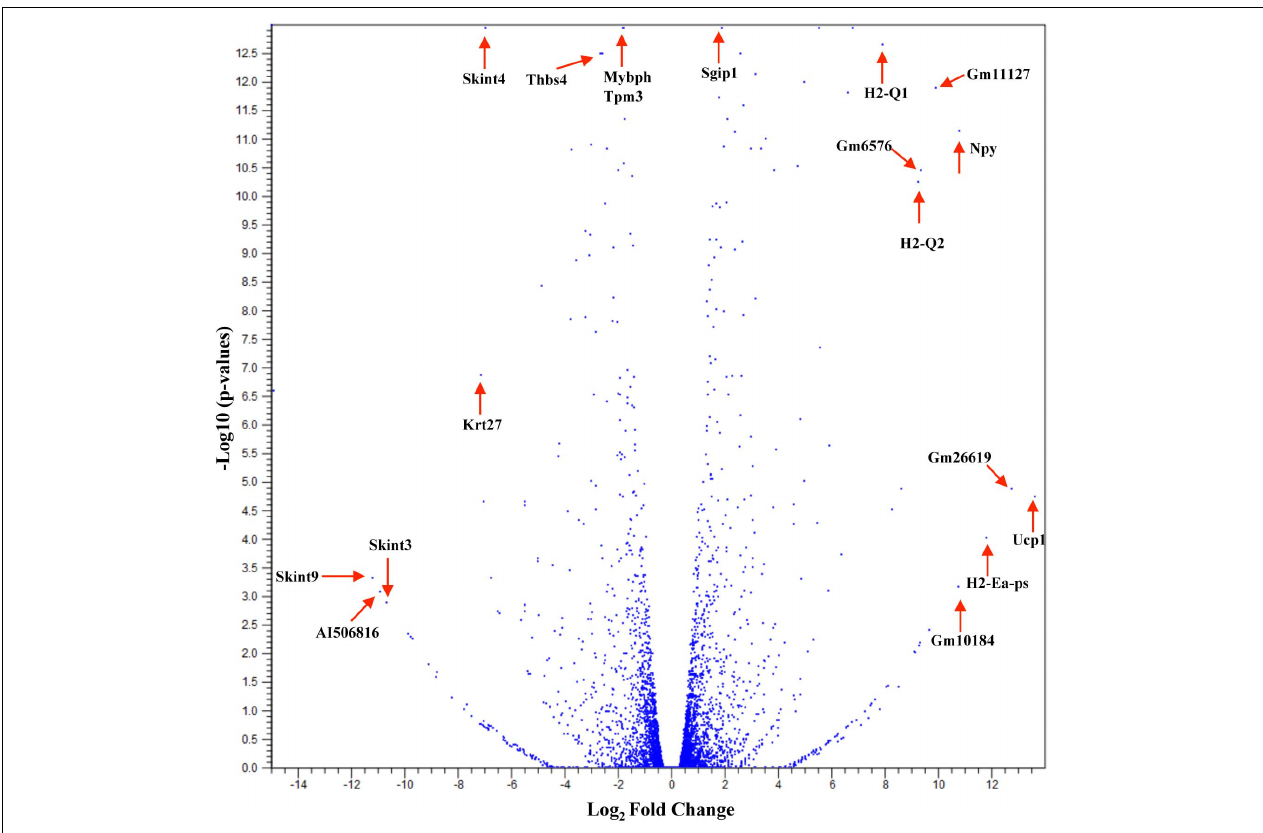
FIGURE 2 | Overall cutaneous gene expression changes in BALB/c versus C57BL/6 skin. Total RNA was isolated from untreated C57 and BALB/c normal skin samples and subjected to transcriptome analysis by MiSeq ( n = 6/experimental group). Volcano plot comparing gene expression levels in terms of log 2 fold change versus significance in both group comparisons. The y -axis corresponds to the mean expression value of log 10 ( p -value), and the x -axis displays the log 2 fold change